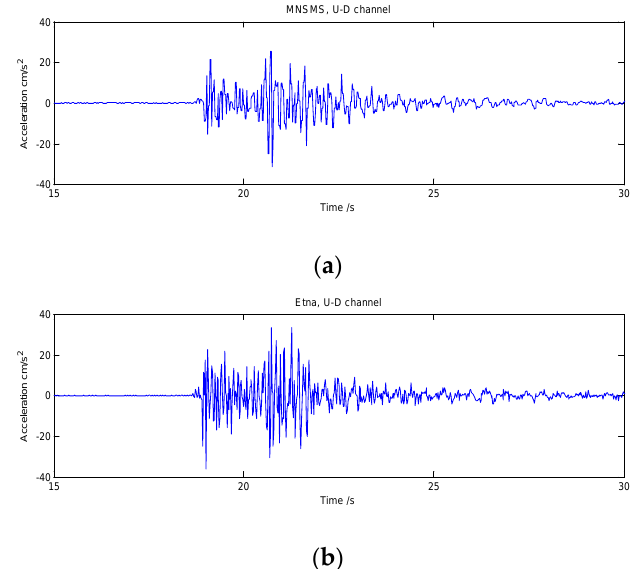
Figure 4. U-D channel records of earthquake M 4.3 occurred at Lat. 29.2° and Lon. 102.3° on May 16, 2018 4:46 pm obtained by the sensor SMCLX and the sensor Etna: ( a ) U-D channel record was obtained by the sensor SMCLX. ( b ) U-D channel record was obtained by the sensor Etna.